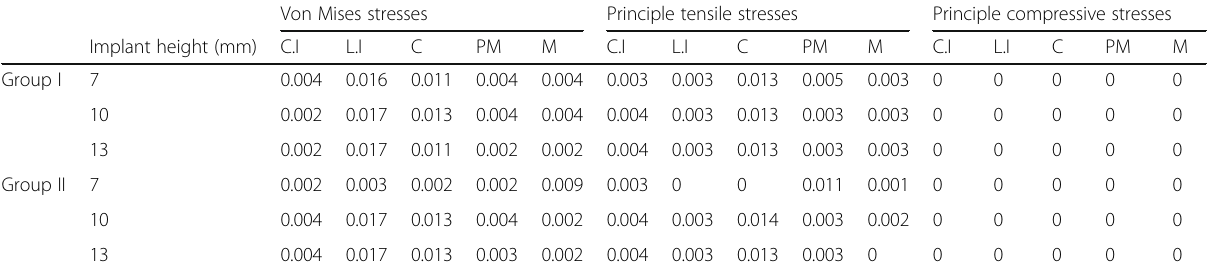
Table 5 Stresses on PDL in Mega Pascal in group I and group II in consolidation models Von Mises stresses Principle tensile stresses Principle compressive stresses